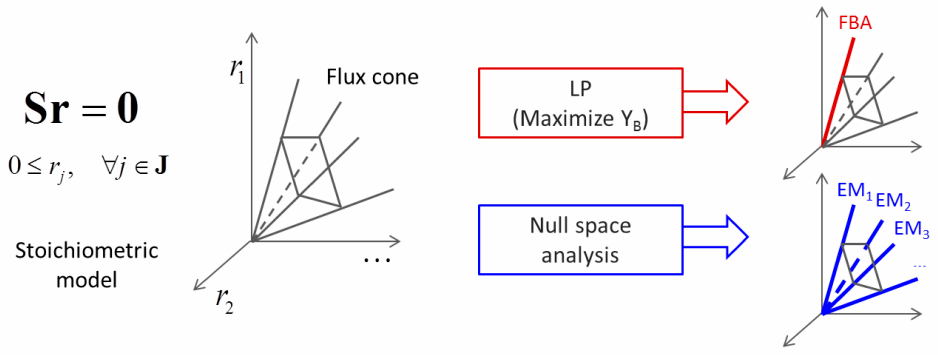
Figure 4. A schematic illustrating the concept of flux balance analysis (FBA) and elementary mode (EM)